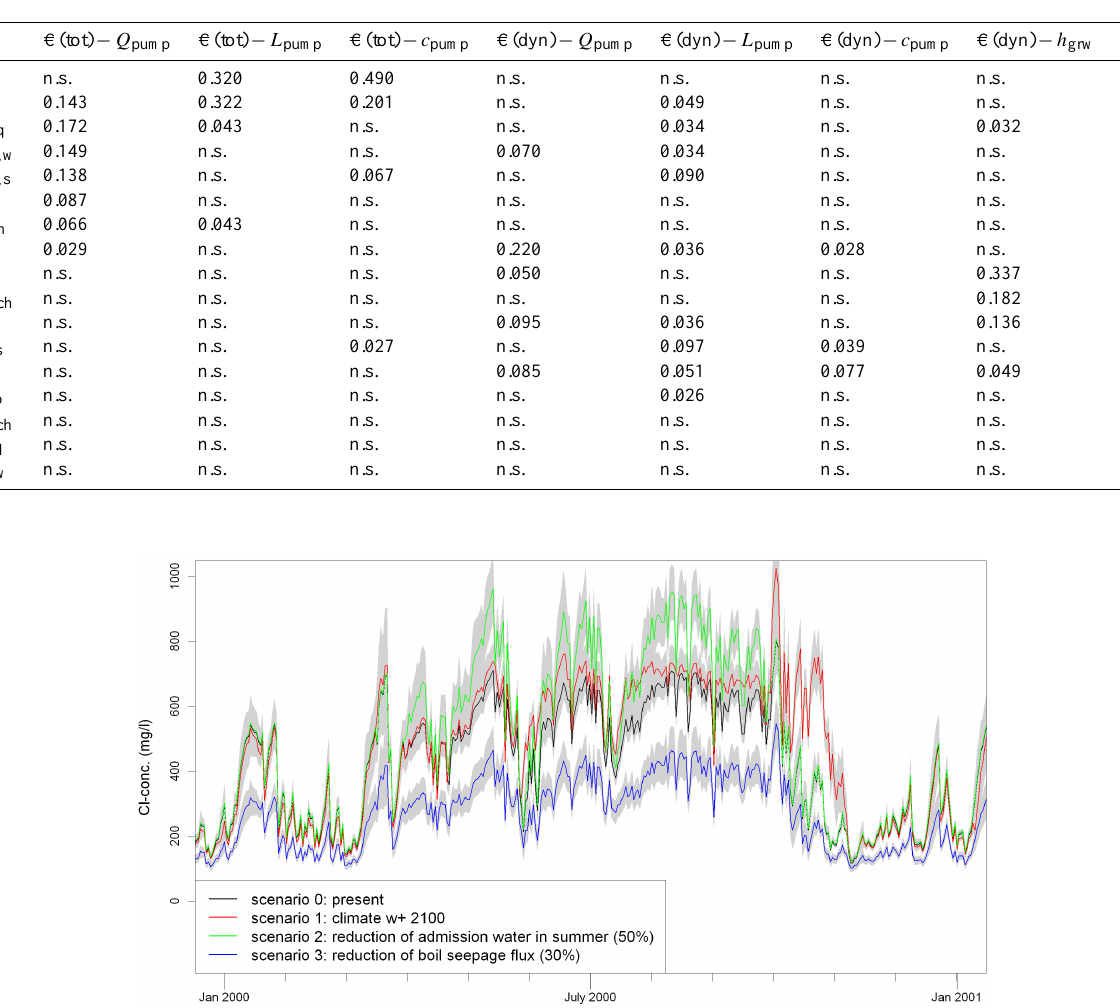
Table 5. Global sensitivity analysis results. The R 2 for correlations between model input parameter values and model output error C(tot=entire simulation period, dyn=dynamic, measurement time scale) and the Kolmogorov D statistics for each behavioural parame- ter distribution from GA-B. Not significant (n.s.) when R 2 < 0.025.